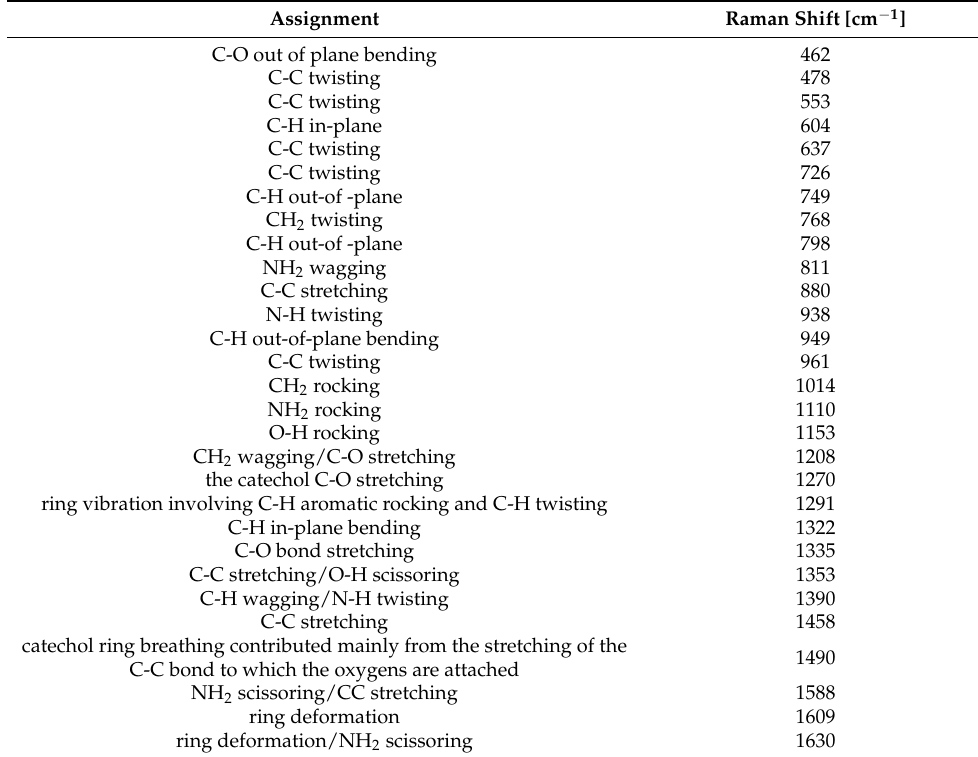
Figure 3. SERS spectrum of (a) the nanostructured silver electrode before the adsorption of dopamine and (b) the nanostructured silver electrode immersed in a 10 − 5 M aqueous solution of dopamine. Excitation wavelength: 532 nm. Accumulation time: 40 s. The spectra was averaged from 10 measurements. Table 1. Assignments of the SERS bands of dopamine based on the DFT calculations (according to refs.